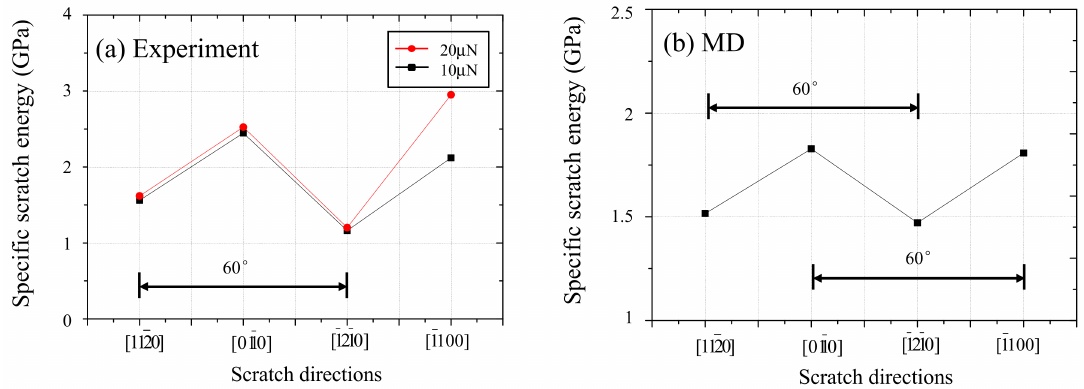
Figure 13. Comparison between ( a ) experimental and ( b ) simulation results regarding the effect of scratching direction on specific scratch